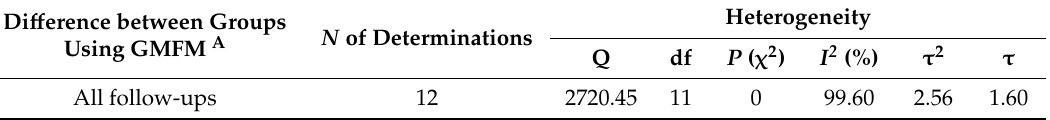
Figure 4. Pre–post difference of the Gross Motor Function Measure (GMFM) scale between groups in all follow-ups. Table 6. Global heterogeneity between groups on the GMFM scale: all follow-ups.